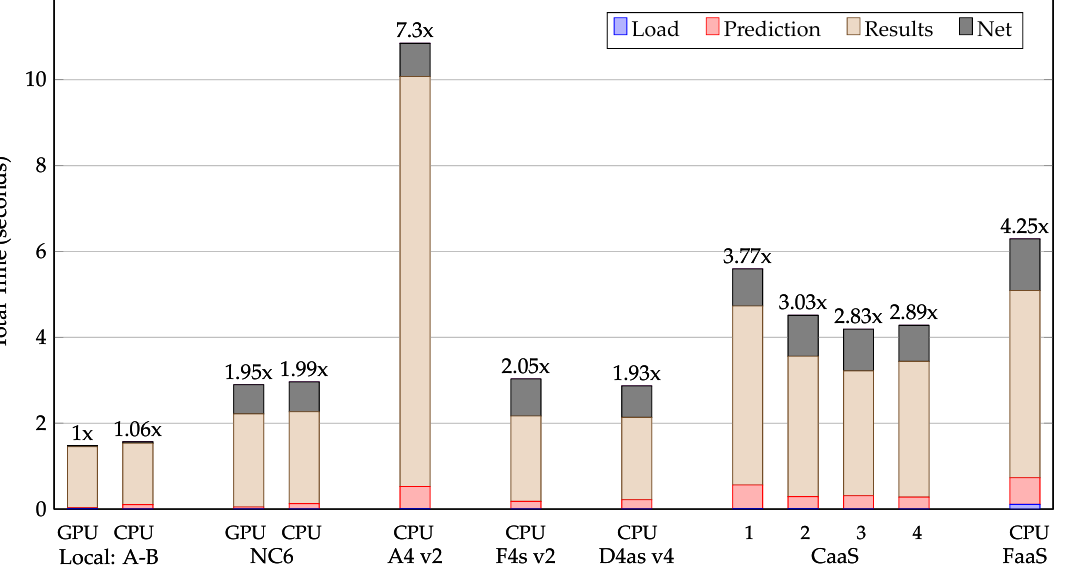
Figure 19. Performance in seconds per infrastructure.